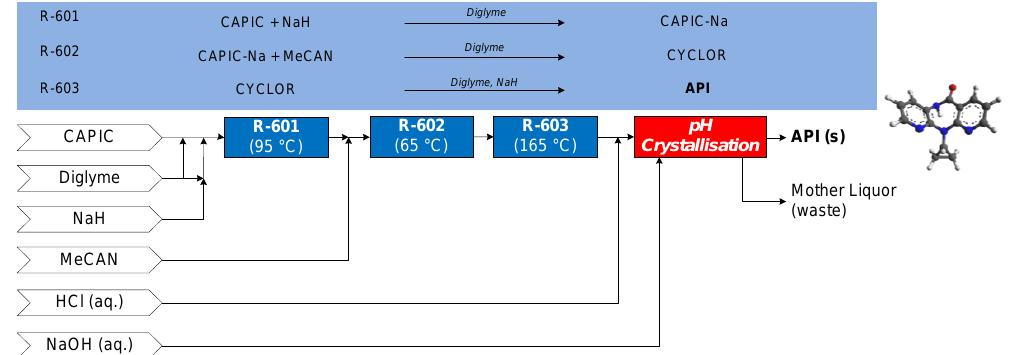
Figure 16. CPM flowsheet for nevirapine: flow synthesis [71] + continuous crystallization [72]. Reproduced with permission from Diab et al., Organic Process Research & Development; published by American Chemical Society, 2019.